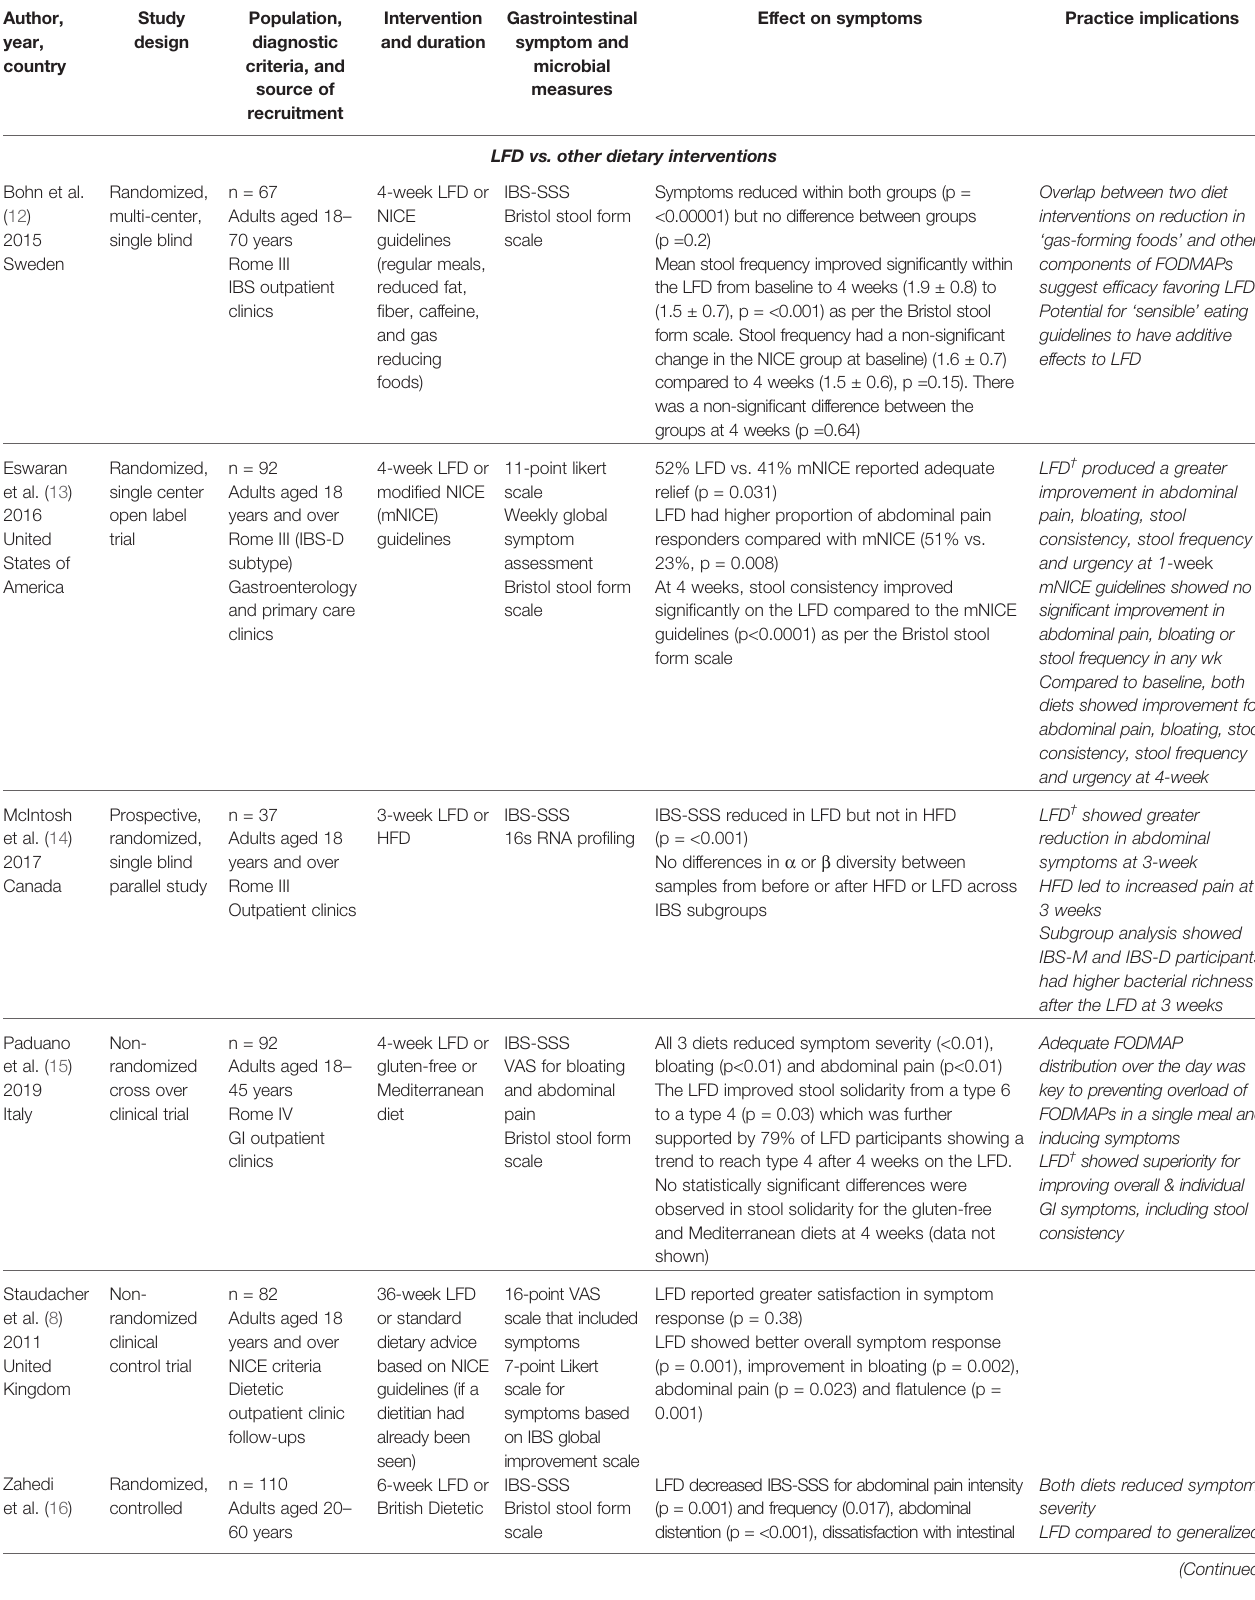
TABLE 1 | Summary of trials reporting on the assessment of the low FODMAP diet compared with other interventions in the management of